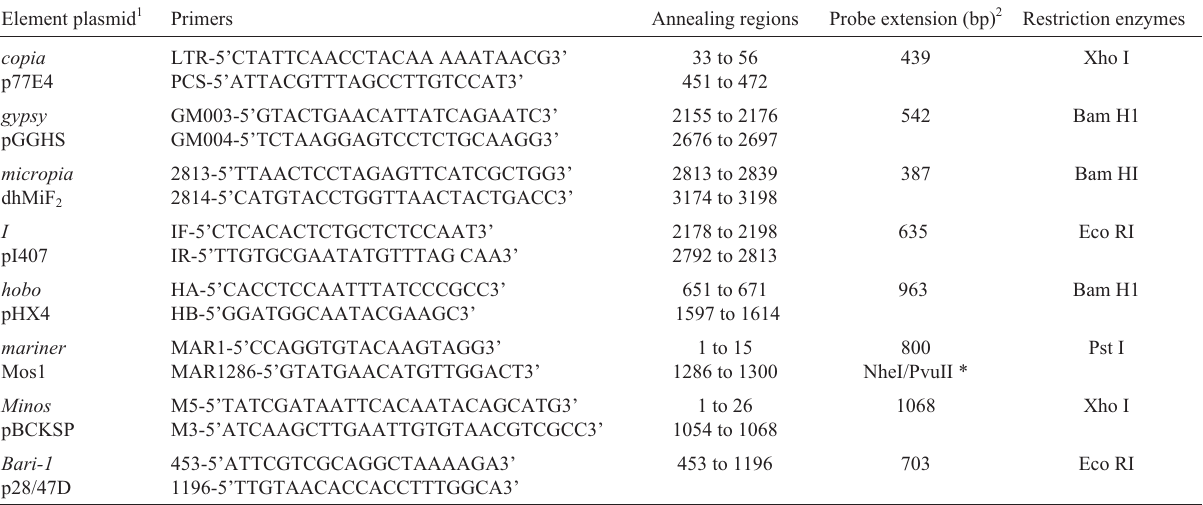
Table2 -Primers,probesandrestrictionenzymesusedforthecopynumberdetectionofeachtransposableelementin saltans group Drosophila species. Element plasmid